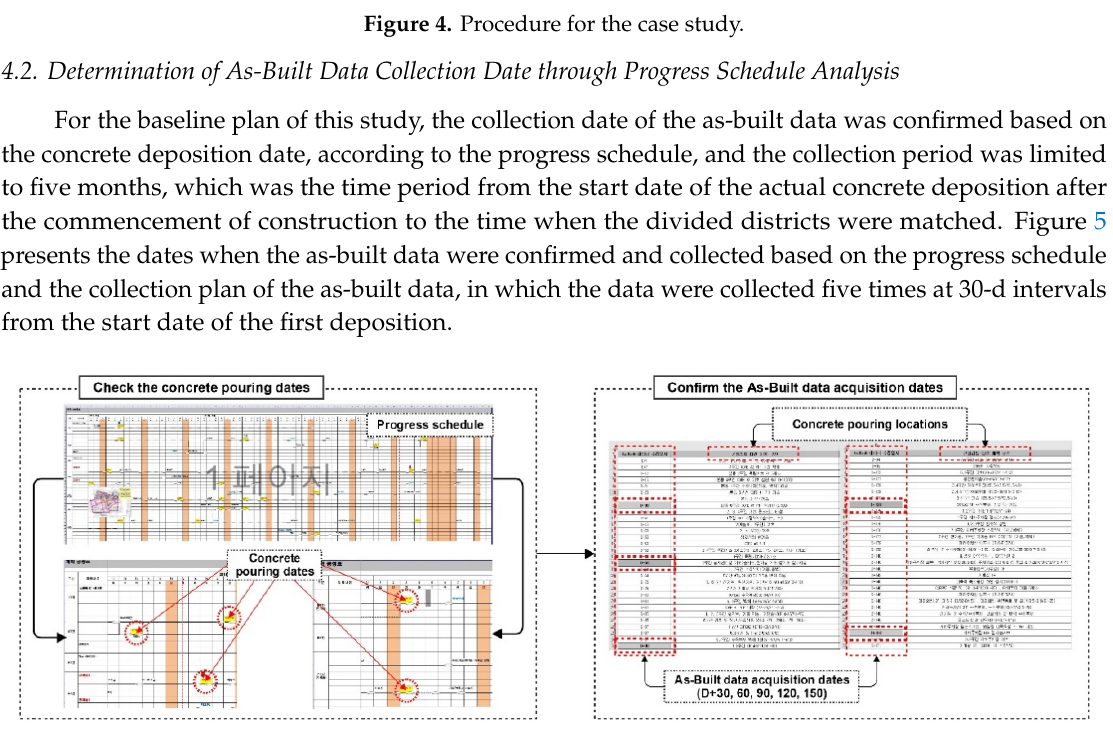
Figure 5. As-built data collection plan based on the progress schedule.